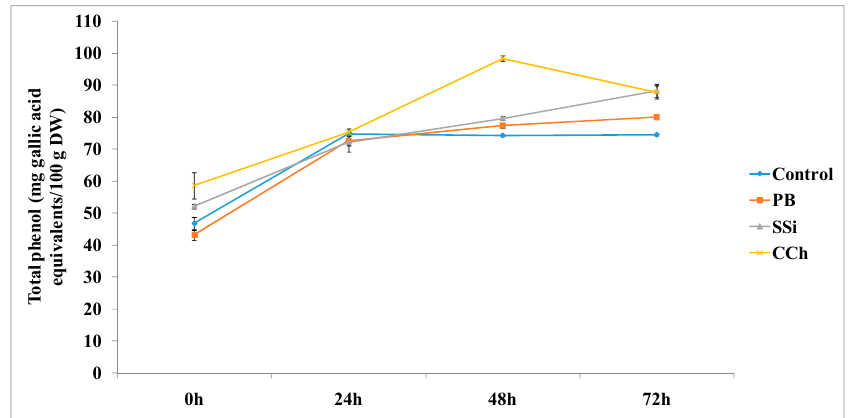
Figure 6. Time course of phenol content (mg gallic acid equivalents/100 g DW) in extracts from table grape cv. Italia peel treated or not with PB, SSi and CCh. All the values are the means of three replicates ± SE.